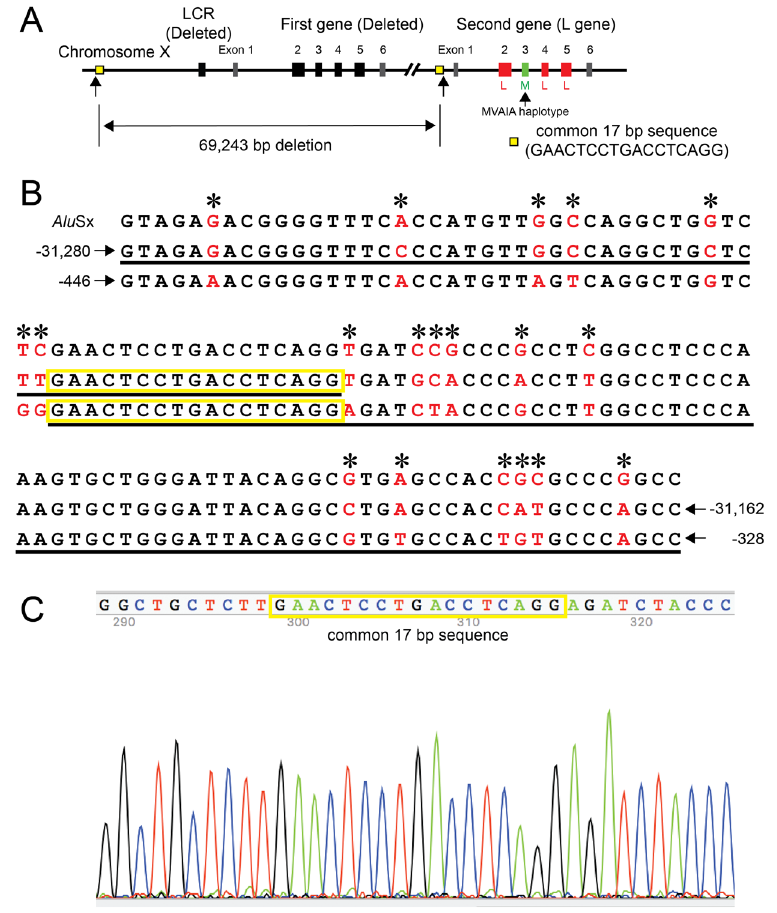
Figure 4. Genotype of Case 3. ( A ) Overview of the genotype of Case 3. Case 3 had a large deletion of 69,243 bp including the LCR and first gene. The remaining second gene was an L gene in which exons 2, 4, and 5 were L type. Exon 3 was M type with MVAIA haplotype. ( B ) Upper row shows the consensus sequence for the left monomer of the Alu element (complementary sequence of AluSx). Middle row shows a part of the upstream region of the first gene (number is from the cap site of the first gene). Lower row shows a part of the upstream region of the downstream gene (number is from the cap site of the downstream gene). The nucleotides differing among the regions are shown in red and by asterisks. The actual sequence obtained in Case 3 is underlined. ( C ) Partial sequence data around the breakpoint of the deletion. The breakpoint is somewhere in the common 17-bp